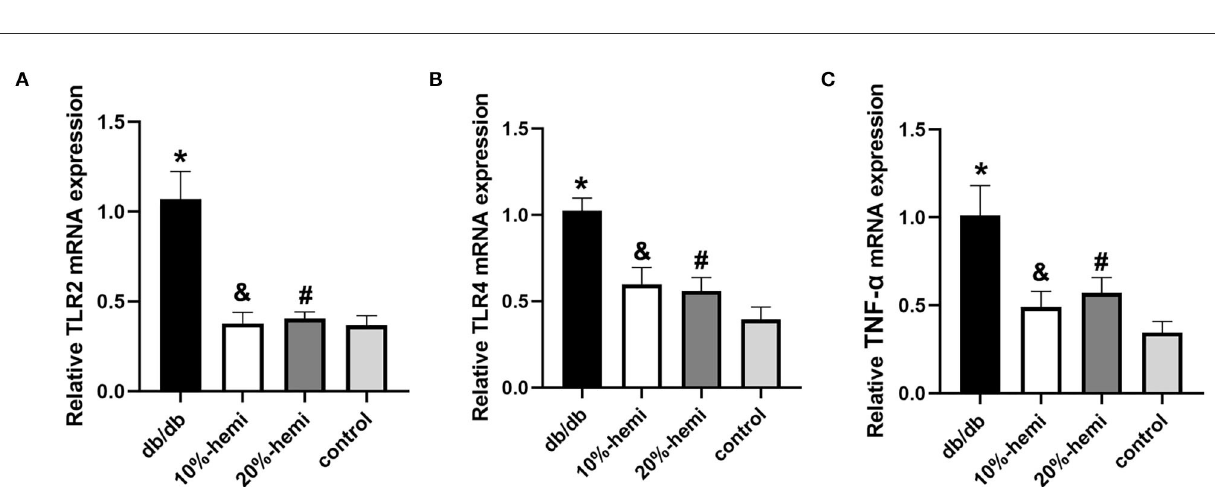
hemicellulose alleviated the impaired gut barrier and helped to control hyperglycemia by lowering systemic